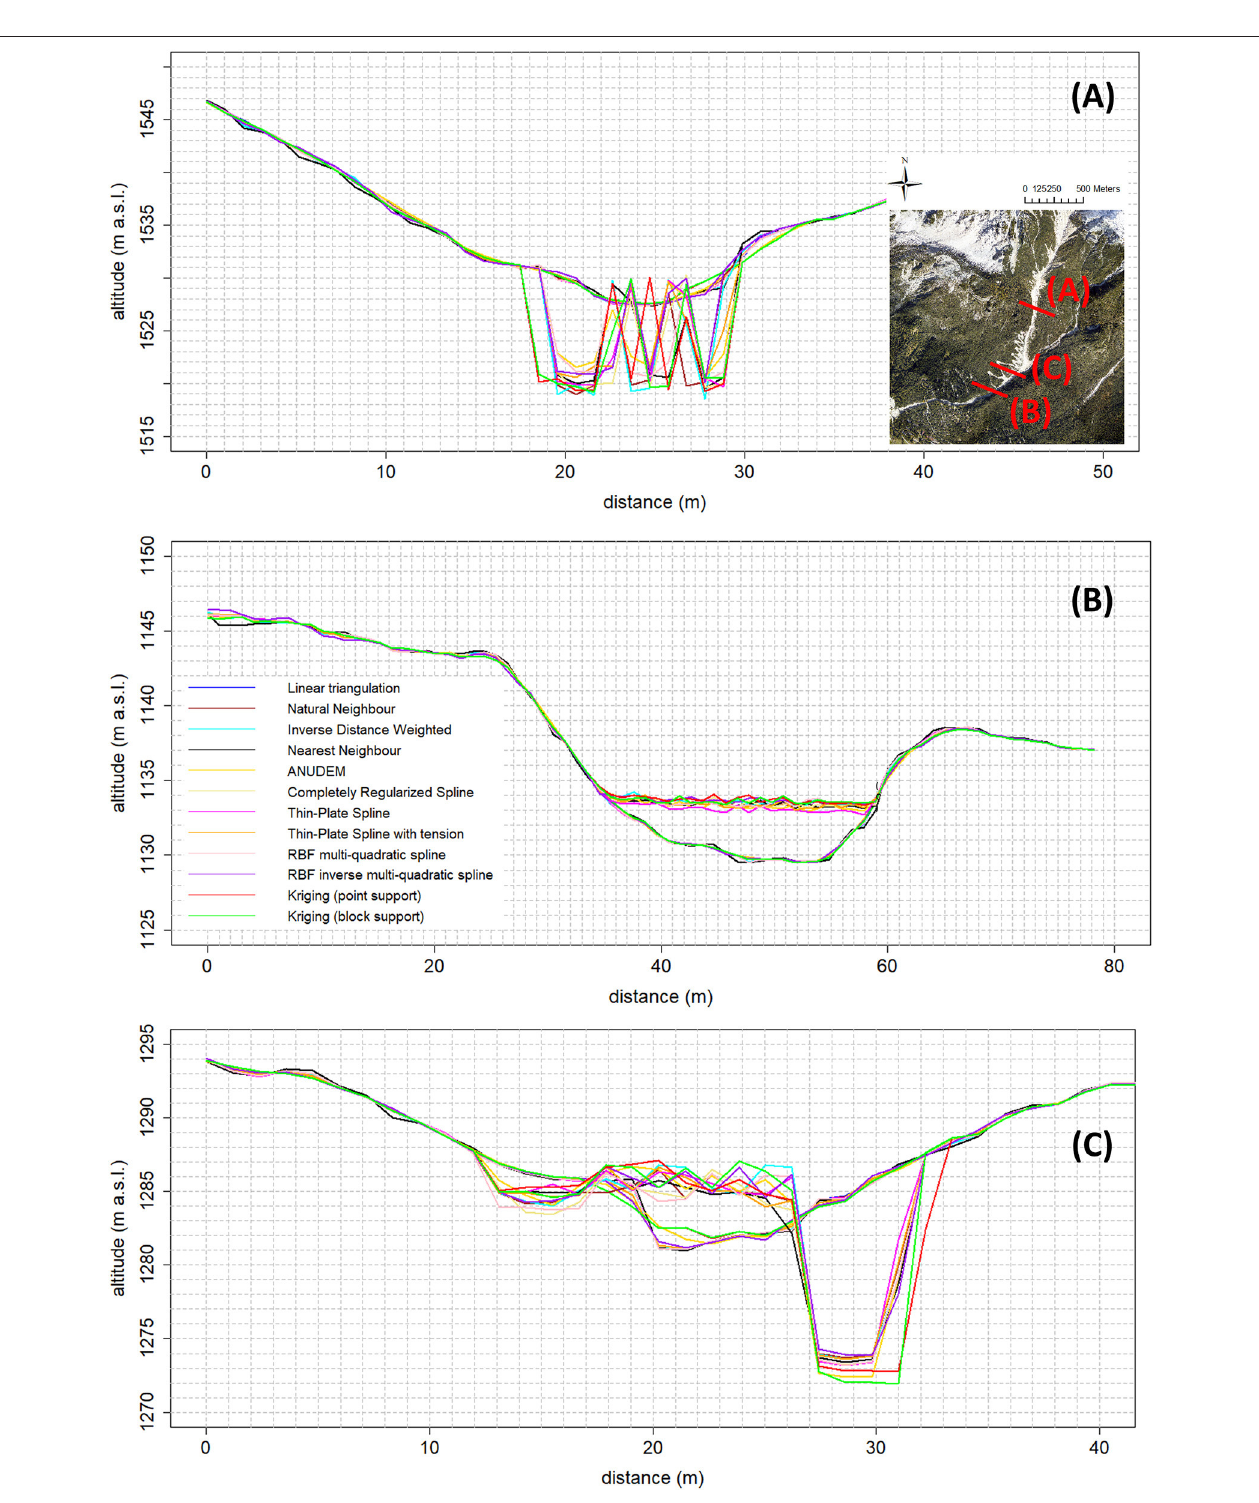
FIGURE 12 | Comparison of the pre- (continuous lines) and post-event (dotted lines) DEMs cross-section profiles (erosional (A) , depositional (B) , and mixed erosional-depositional reach (C) of the Rovina di Cancia debris flow channel).